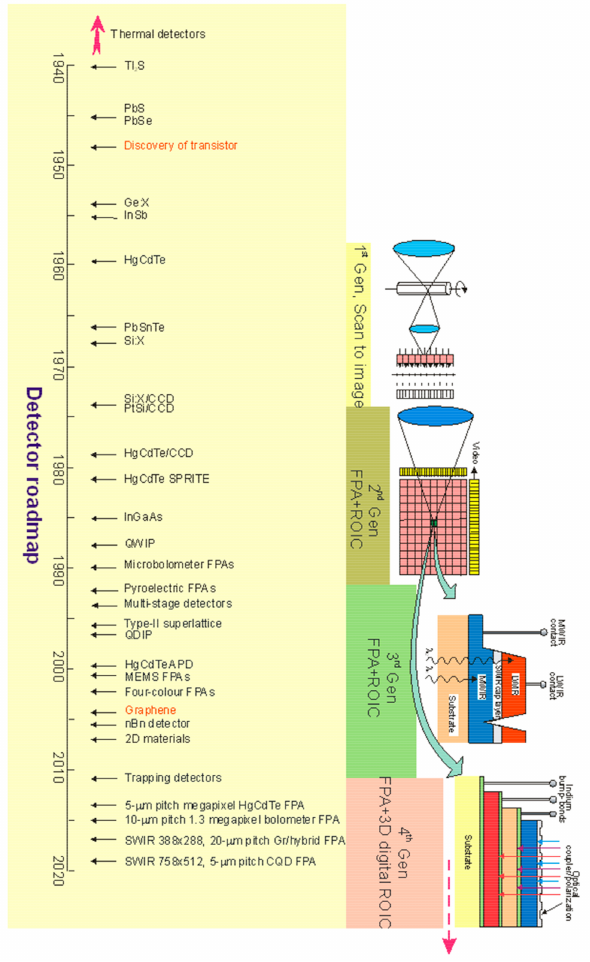
Figure 1. The history of IR detectors and systems development. Four generation systems for military and civilian applications can be considered: first generation (scanning systems), second generation (staring systems—electronically scanned), third generation (staring systems with large number of pixels and two-color functionality), and fourth generation (staring systems with very large number of pixels, multi-color functionality, 3D ROIC, and other on-chip functions; e.g., better radiation/pixel coupling, avalanche multiplication in pixels, polarization/phase